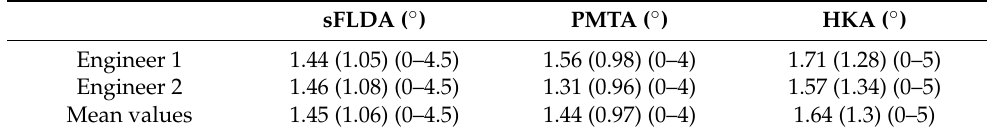
Results are shown as mean value (standard deviation) and (range). sFLDA: supplementary angle of the femoral lateral distal angle (90 ◦ planned), PMTA: proximal medial tibial angle (90 ◦ planned), HKA: hip–knee–ankle angle (180 ◦